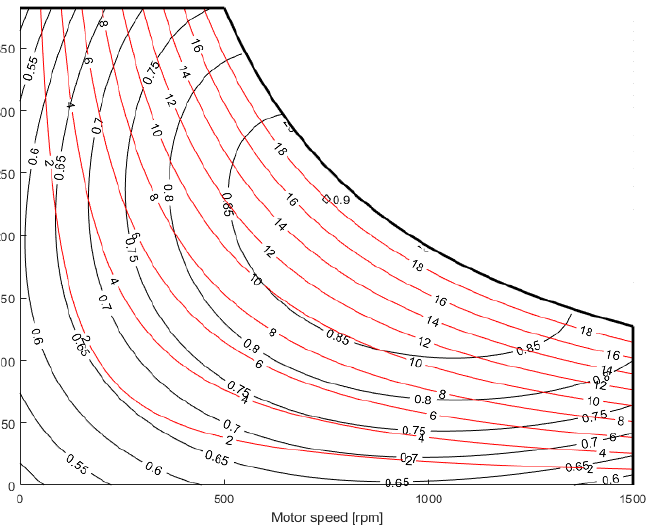
Figure 7. Efficiency map for the electric generator. The thick black line represents the maximum torque curve, black curves represent the iso-efficiency curves and red curves represent the iso-power curves expressed in kW.